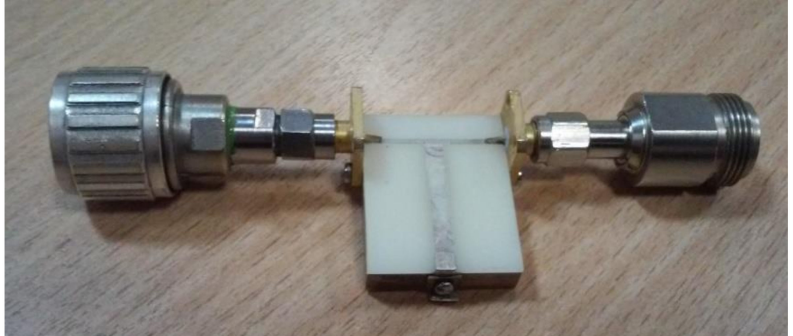
Figure 10. The microstrip cell for measurements in the 3.2–4.8 GHz frequency